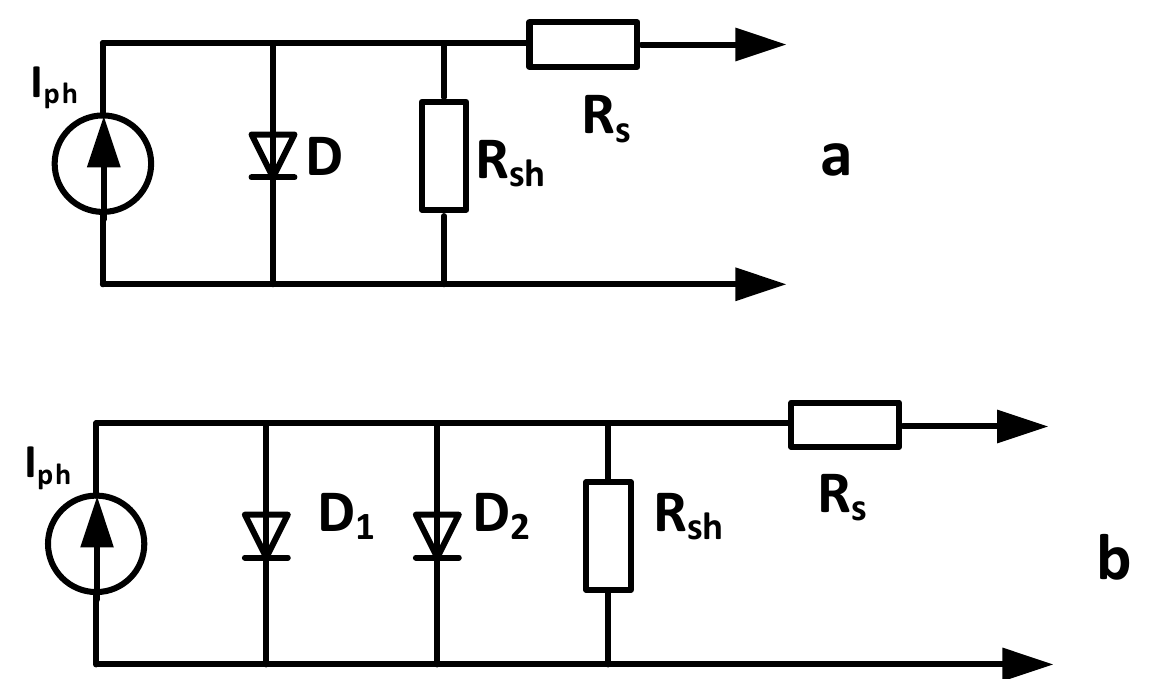
Figure 2. The general single ( a ) and two diode ( b ) equivalent circuits for a PV cell. As demonstrated in the above-shown equivalent circuit of a PV cell, the single-diode model can be used as a current source [14]. This model is described in detail by